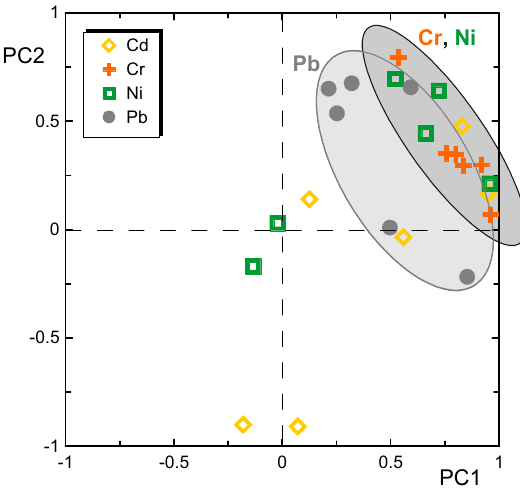
Figure 7. Principal component analysis plot of the soil samples (PC1 and PC2).